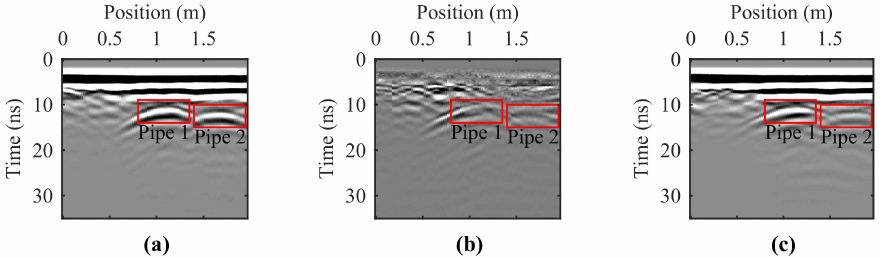
Figure 18. Real full-polarimetric data of two pipes. (a) HH polarization, (b) HV polarization, (c) VV polarization.